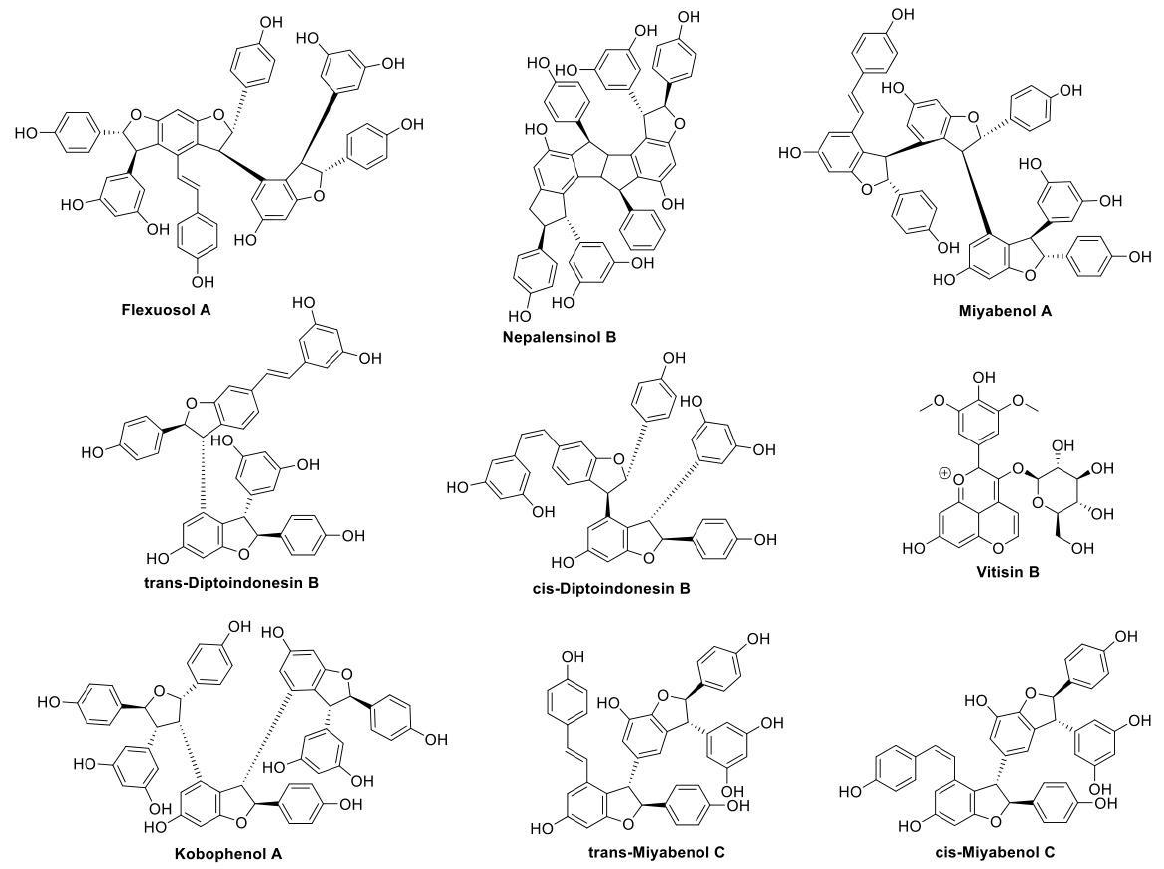
Figure 5. Commercially available compounds yielded from the cheminformatic screening procedure, searching for NPs similar to Ampelopsin H, that can potentially block the TNF trimer formation.